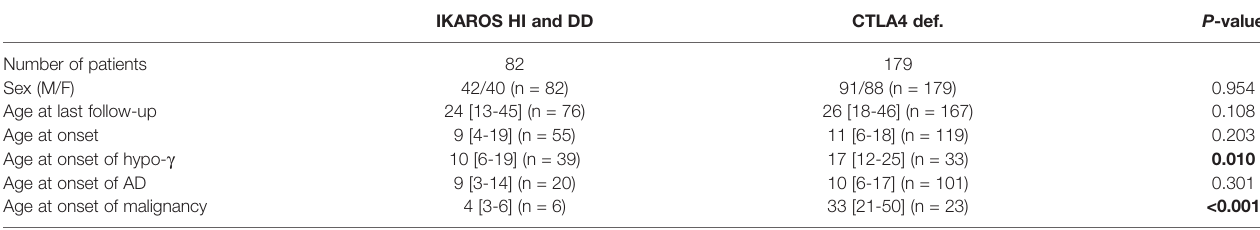
TABLE 1 | Baseline description of individuals with IKAROS de fi ciency (HI and DD) and CTLA4 de fi ciency in the systematic literature reviews. IKAROS HI and